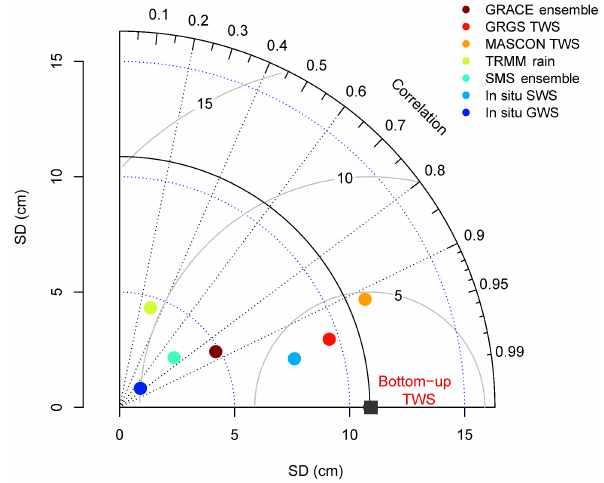
Figure 9. Taylor diagram shows strength of statistical associa- tion, variability in amplitudes of time-series records and agree- ment among the reference data, bottom-up (cid:49) TWS and GRCTellus GRACE-derived (cid:49) TWS (ensemble mean of CSR, GFZ, and JPL, GRGS and JPL-Mascons (cid:49) TWS time-series records), simulated (cid:49) SMS (ensemble mean of NOAH, CLM and VIC), in situ (cid:49) SWS, and in situ (cid:49) GWS over the LVB. The solid arcs around the refer- ence point (black square) indicate centred root mean square (RMS) differences among bottom-up (cid:49) TWS and other variables, and the dashed arcs from the origin of the diagram indicate variability in time-series records. Data for the LVB are only shown in this dia-